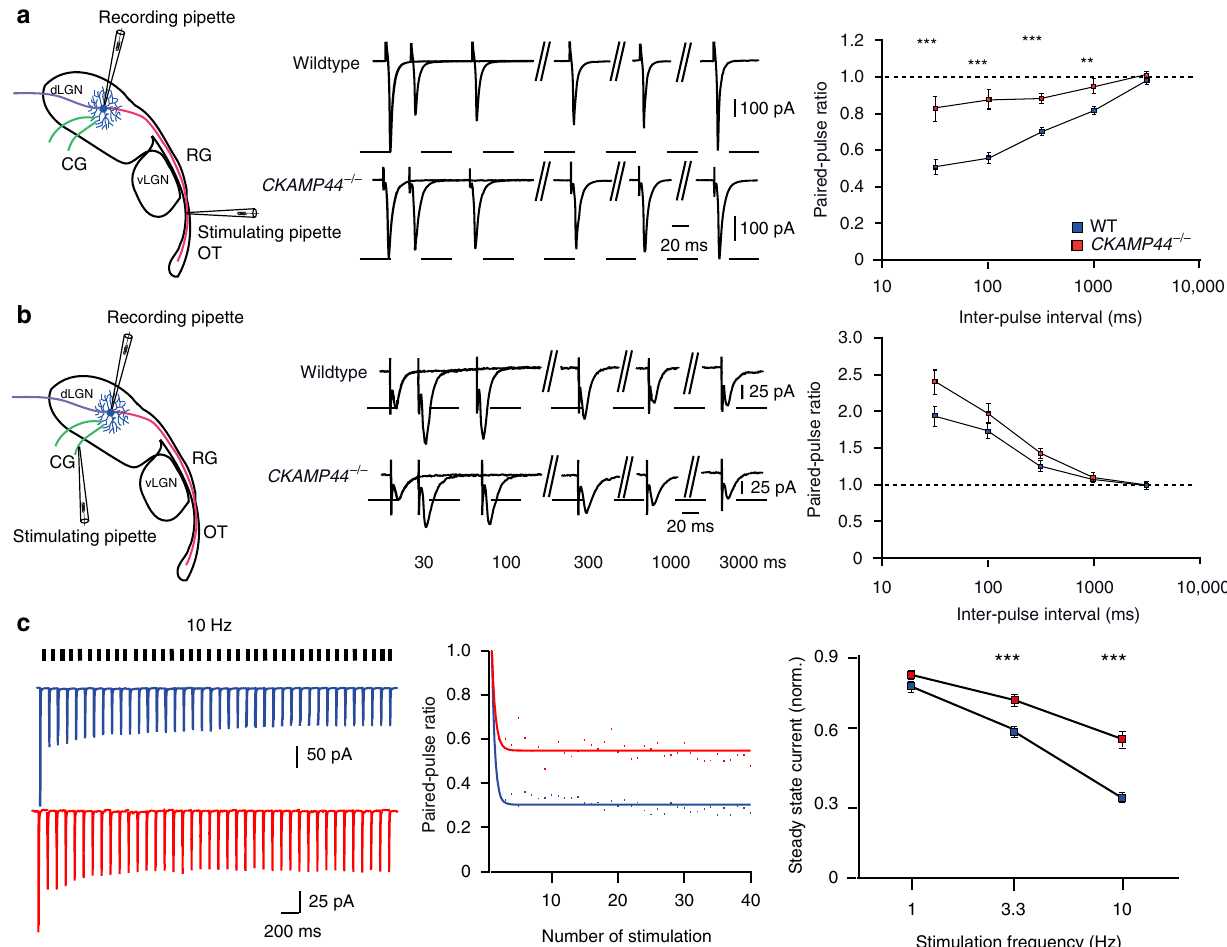
Fig. 2 CKAMP44 modulates synaptic short-term plasticity in retinogeniculate synapses. a The PPR is increased in retinogeniculate synapses of CKAMP44 − / − mice ( n = 20 for relay neurons of wildtype and 18 for relay neurons of CKAMP44 − / − mice, mean ± SEM, 300 ms inter-stimulus interval: t -test; 10 – 1000ms inter-stimulus interval: Mann – Whitney test). b There is no signi fi cant change in the PPR in corticogeniculate synapses of CKAMP44 − / − mice ( n = 25 for relay neurons of wildtype and 22 for relay neurons of CKAMP44 − / − mice, mean ± SEM, 300ms and 3000 ms inter-stimulus interval: t -test, 10, 30, 100, and 1000ms inter-stimulus interval: Mann – Whitney test). A schematic representation of RG and CG synapse activation with localization of stimulation pipettes is shown on the left of a , b . Example traces of pairs of currents that were evoked with two extracellular stimulations with different inter- pulse intervals (30, 100, 300, 1000, and 3000 ms) are shown in the middle. c The steady-state amplitude of synaptic currents is reduced in CKAMP44 − / − mice when stimulating retinogeniculate synapses ×40 at 3.3 or 10 Hz (1 Hz; n = 25 for relay neurons of wildtype and 22 for relay neurons of CKAMP44 − / − mice, 3.3 Hz; n = 31 for relay neurons of wildtype and 24 for relay neurons of CKAMP44 − / − mice, 10 Hz; n = 33 for relay neurons of wildtype and 27 for relay neurons of CKAMP44 − / − mice). The amplitudes were normalized to the amplitude of the fi rst current (mean ± SEM, steady state EPSC amplitudes with 1 Hz stimulation: Mann – Whitney test, other data: t -tests). Example trace of 40 EPSCs evoked by stimulation of retinogeniculate synapses with 10 Hz are shown on the left and a double-exponential fi t of the current amplitudes of the same data in the middle. * p < 0.05, ** p < 0.01, *** p < fi ring of RGCs before they fi re with high frequency due to optimal visual stimuli. As expected from the voltage clamp experiments shown in Fig. 2c, EPSP amplitudes attenuated more in retino- geniculate synapses of wildtype than in those of CKAMP44 − / − mice (Fig. 3c – e and Supplementary Table 14). The amplitude